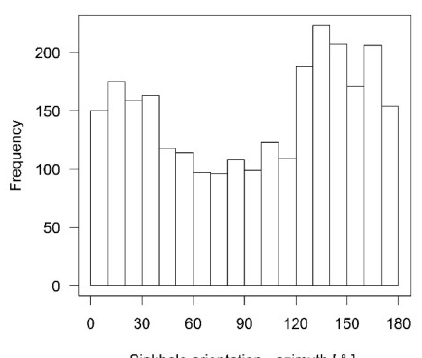
Figure 5. Frequency distribution of orientations of the detected sinkholes.